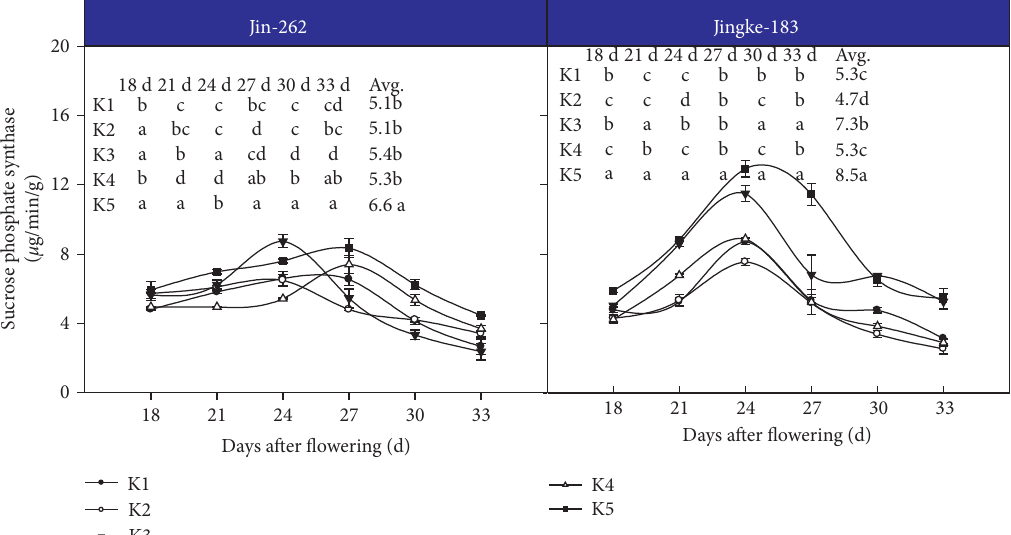
Figure 5: Effects of potassium on grain sucrose phosphate synthase (SPS) activity of fresh-eaten maize kernel fresh weight. The different lowercase letters are significant differences at the 5% level; AVG, average; the bars are standard deviation ( n �